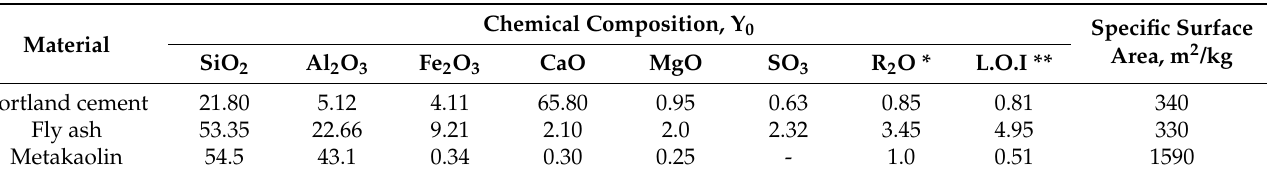
Table 1. Characteristics of raw